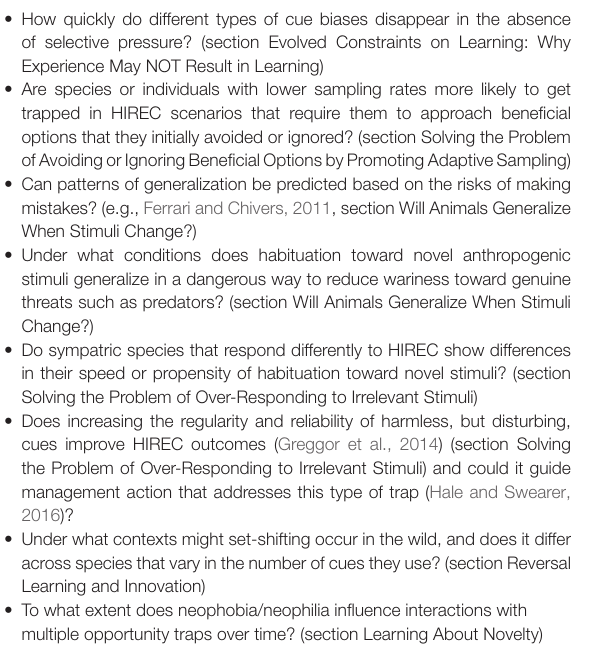
TABLE 1 | Summary of future research